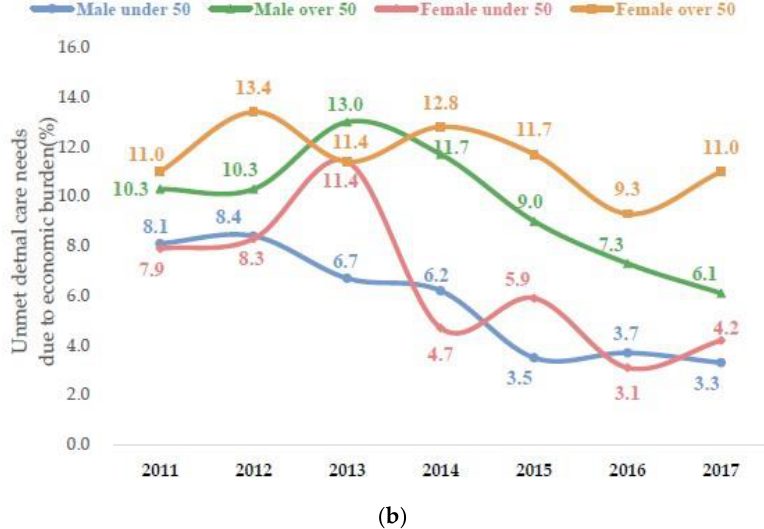
Figure 2. ( a ) Unmet dental care needs by gender and age group. ( b ) Unmet dental care needs due to economic burden by gender and age group. Table 3. Rates of unmet dental care needs according to the characteristics of Korean workers from the Korea Health Panel Survey (2011–2017) †